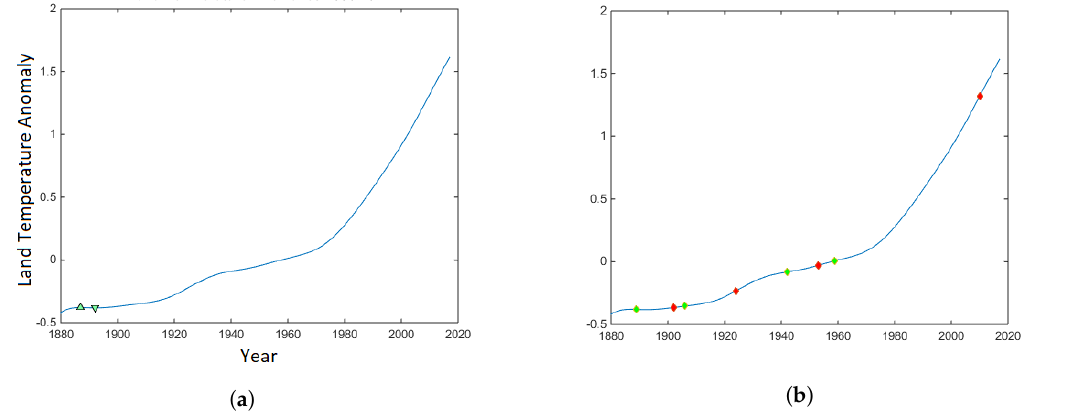
Figure 1. Land Temperature: ( a ) Detected maximum (upward green arrow) and minimum (downward green arrow) in the Land Temperature anomalies (Y axis) between 1880 and 2017 (X axis); ( b ) Identified inflection points in the Land Temperature anomalies (Y axis) between 1880 and 2017 (X axis). Positive inflection point (red diamond); negative inflection point (green diamond).